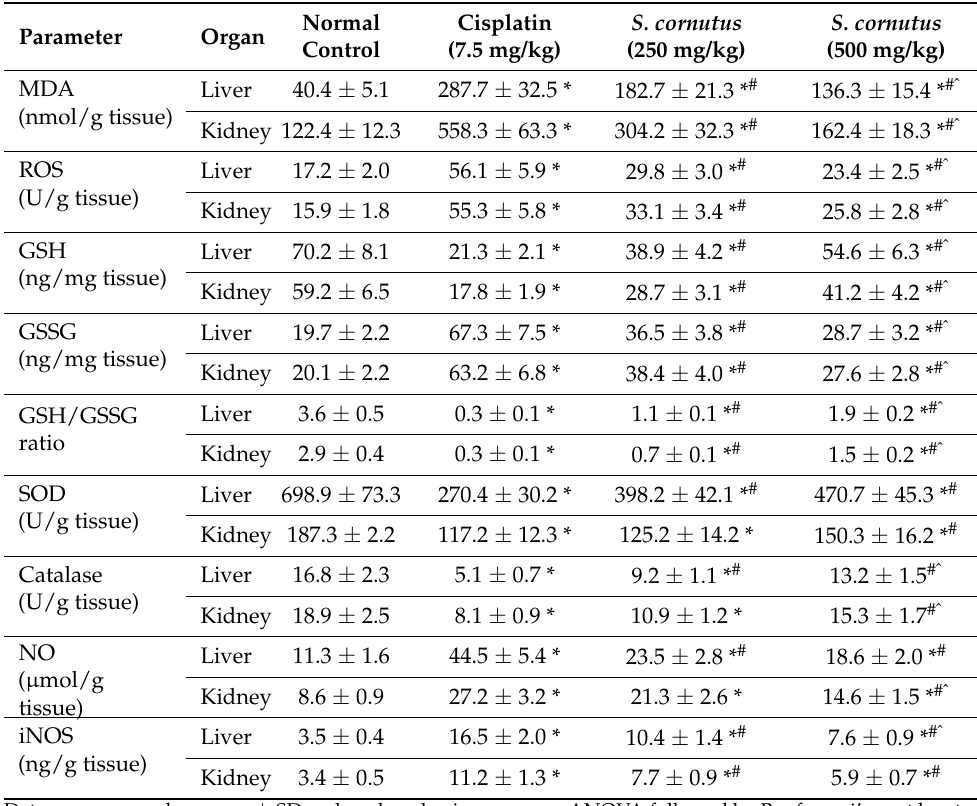
Table 5. The effect of S. cornutus crude extract on the levels of oxidative stress markers in the liver and kidney tissues of the experimental